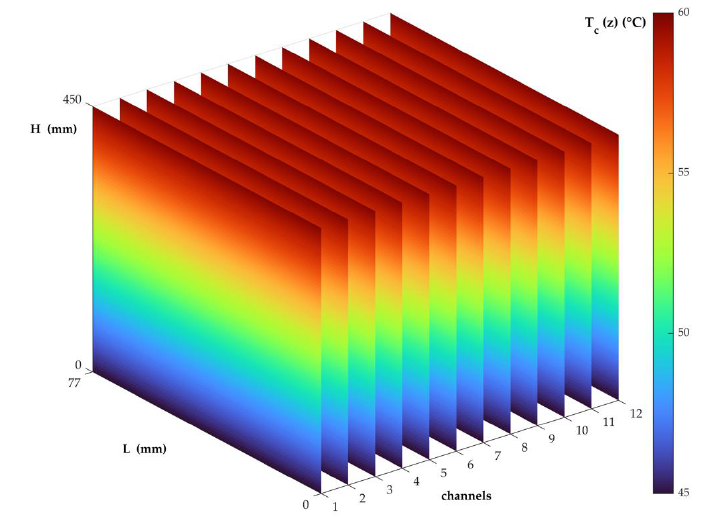
Figure 6. Temperature trend of hot geothermal fluid for Nc = 12 and 𝑇 ℎ,𝑖𝑛 = 115 °C.